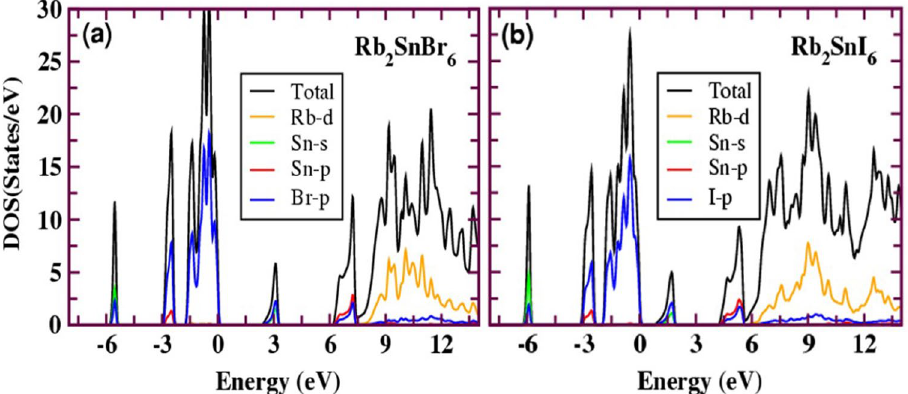
Figure 4. The total and partial density of states (DOS) for ( a ) Rb 2 SnBr 6 and ( b ) Rb 2 SnI 6 computed using mBJ potential. The Fermi level is set to 0